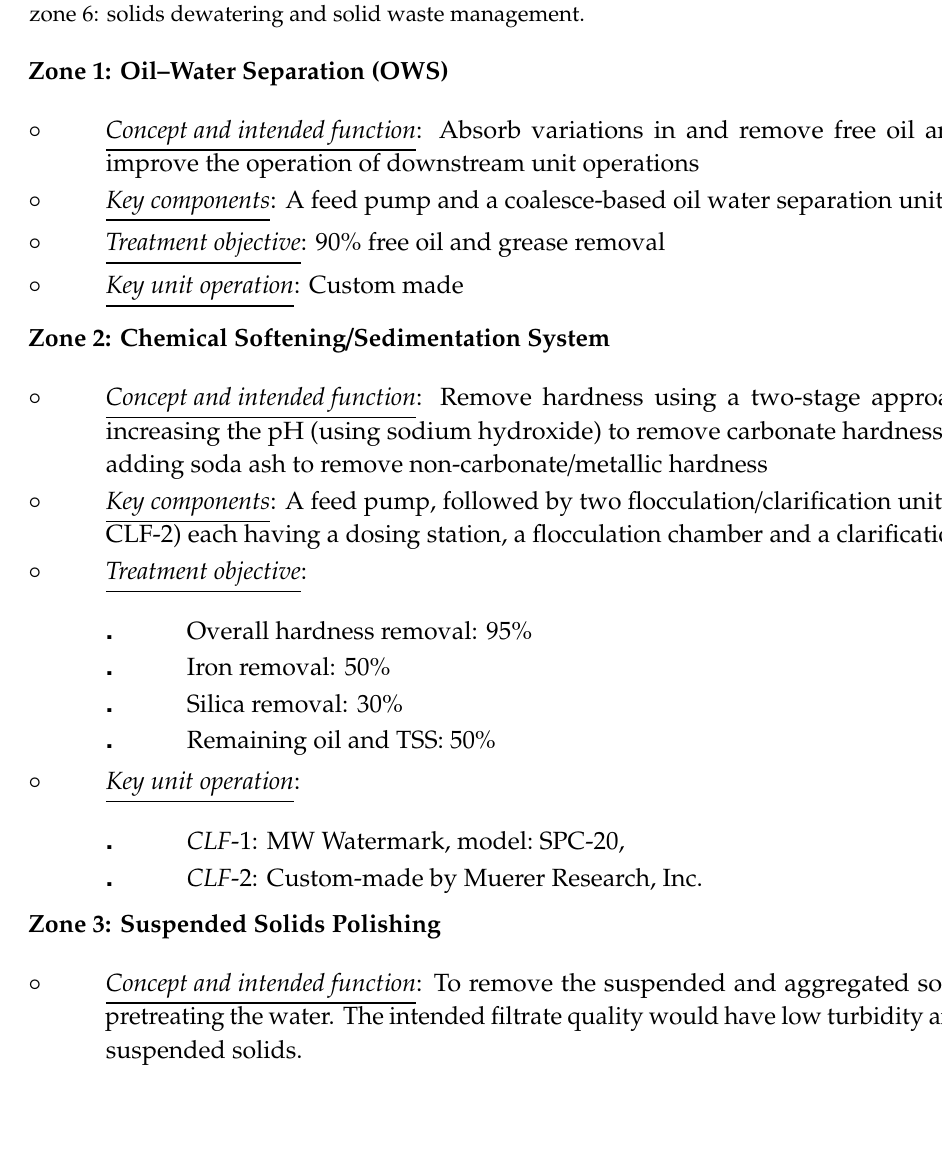
Figure 3. Image of the pilot test site. Zones indicate different water treatment objectives. Zone 1: oil–water separation; zone 2: chemical softening and clarification; zone 3: suspended solids removal; zone 4: dissolved hydrocarbon removal; zone 5: primary desalination and secondary boron removal; zone 6: solids dewatering and solid waste management.